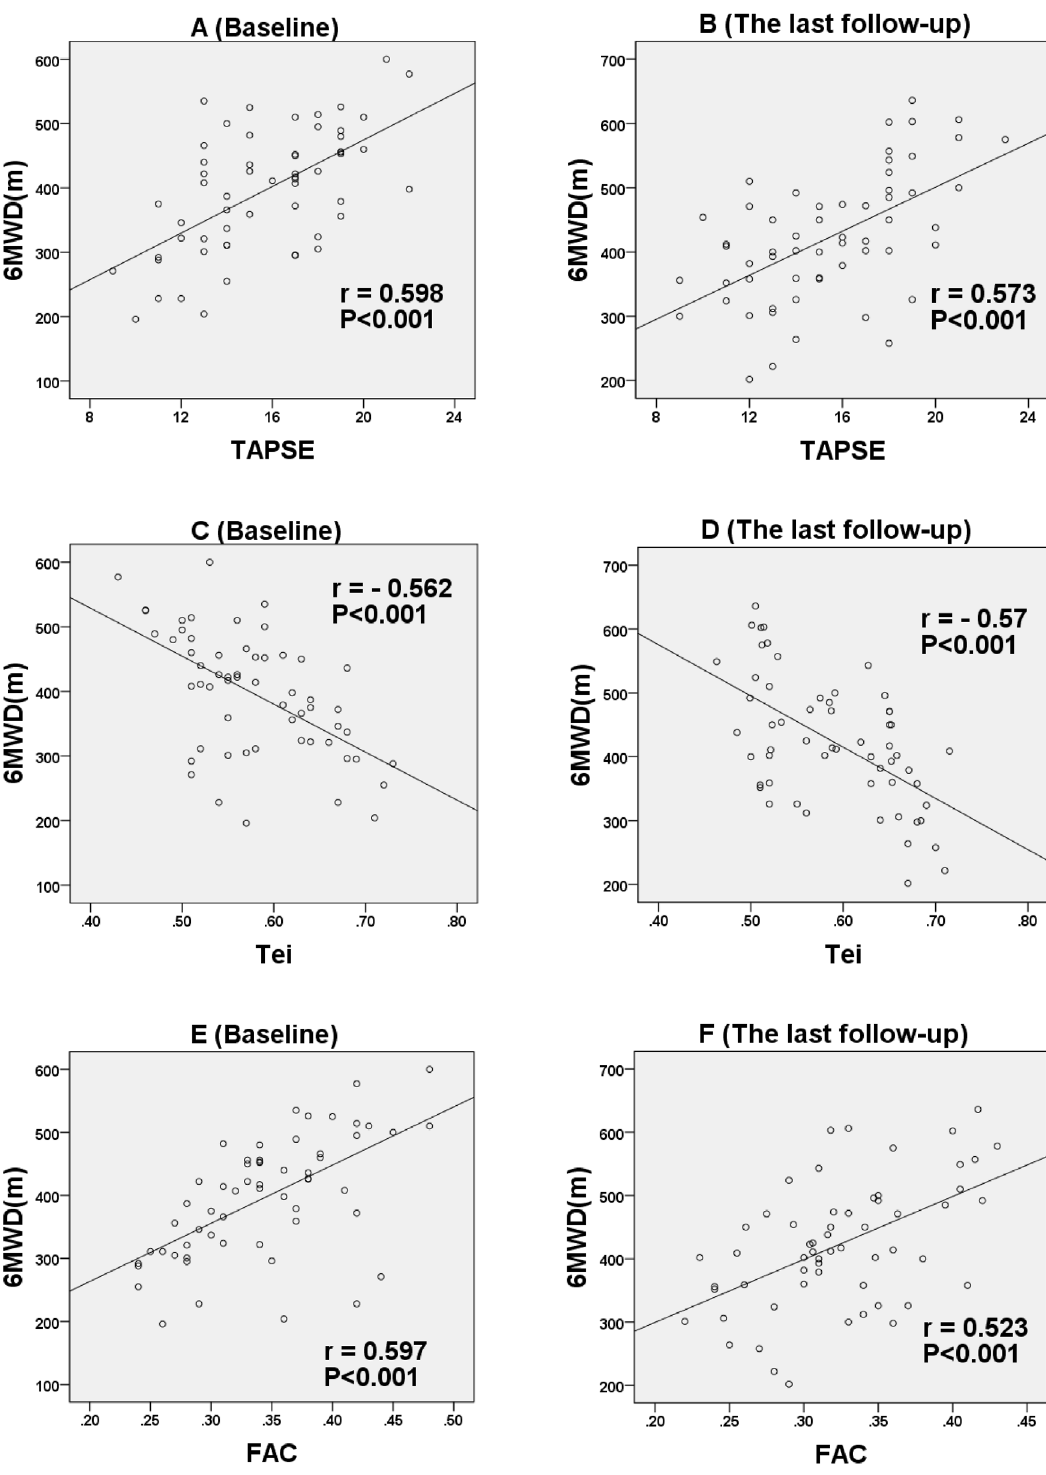
Fig. 5. The relationship between TAPSE, Tei index, FAC and 6MWD at baseline (A, C, E) and the last follow-up (B, D, F).